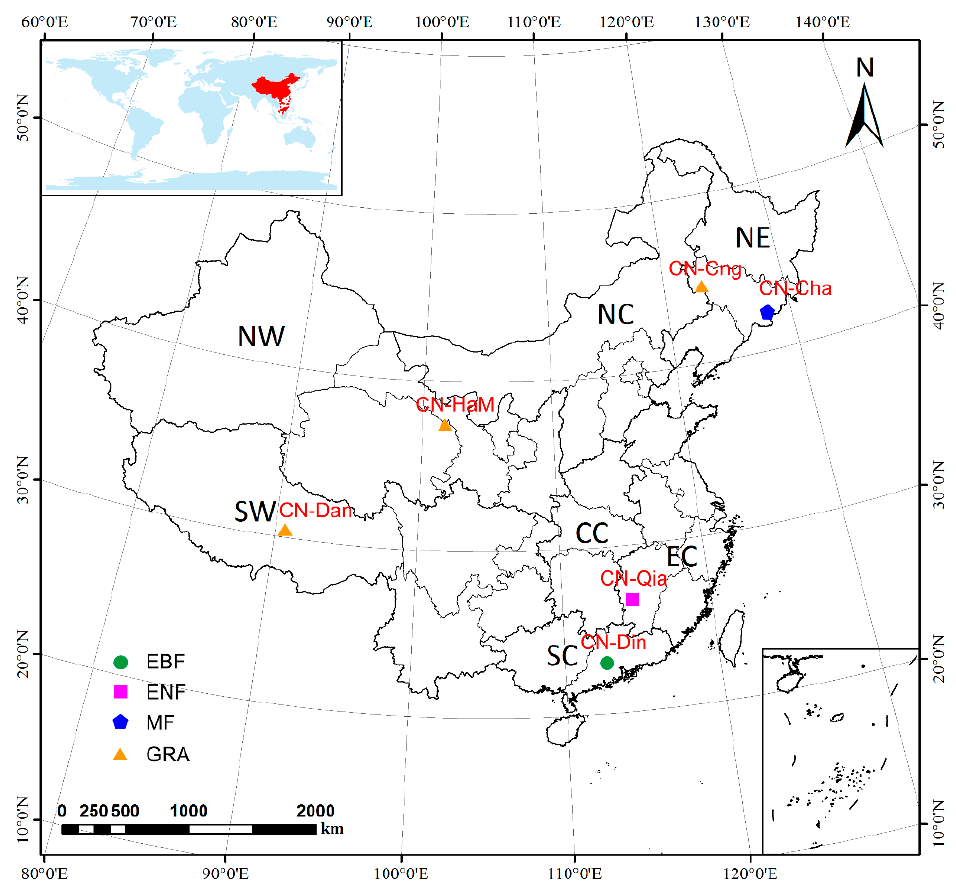
Figure 1. Locations of six flux tower sites used in this study. EBF: evergreen broadleaf forest; ENF: evergreen needleleaf forest; MF: mixed forest; GRA: grassland. The seven geographic regions are: Northwest China (NW), North China (NC), Northeast China (NE), Southwest China (SW), Central China (CC), East China (EC), and South China (SC). Table 1. Description of flux tower sites used for gross primary productivity (GPP) validation in this study.